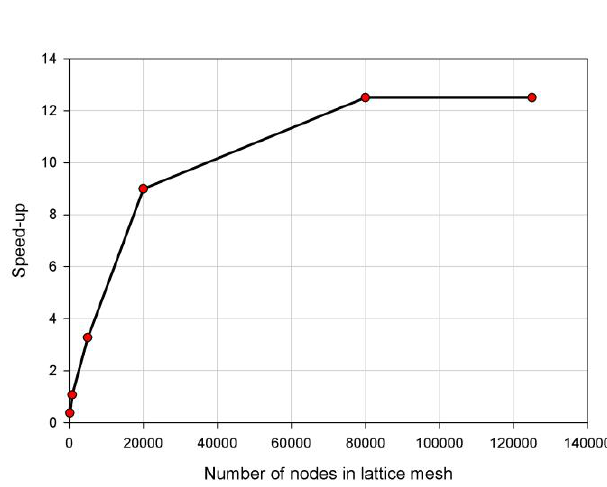
Figure 2 . Diagram of variation of speed-up of parallelized software depending on the number of nodes of lattice mesh